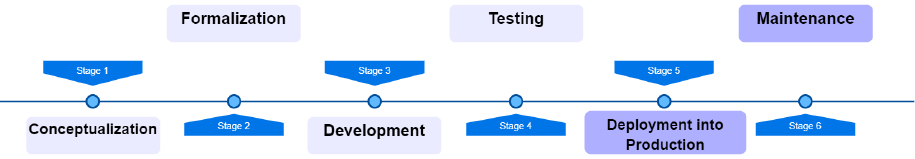
Figure 3. The improved chatbot